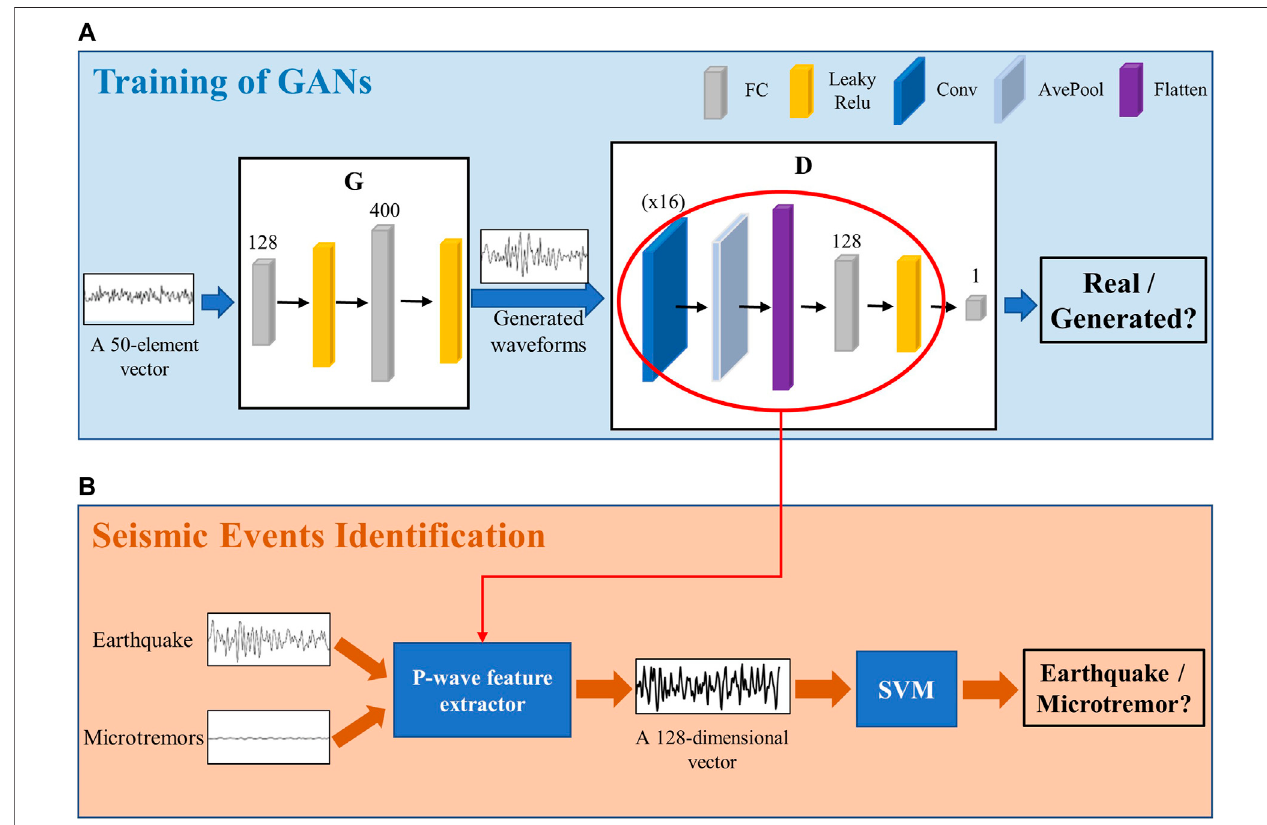
FIGURE 5 | The training process of the combined model in this paper. (A) The training of GANs; (B) The identi fi cation of seismic events.